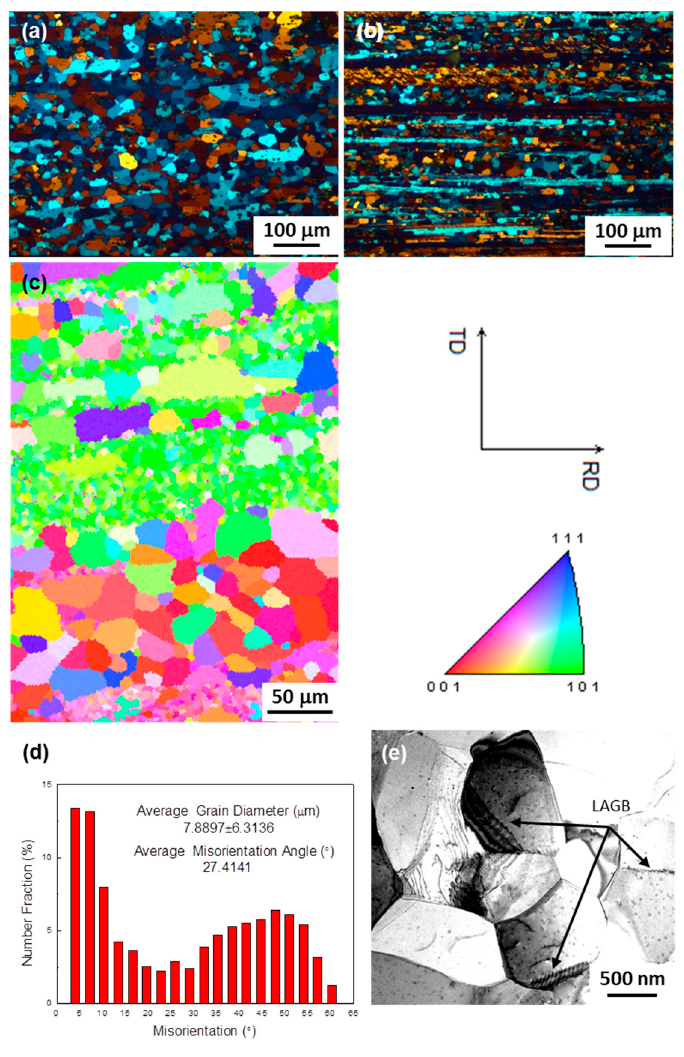
Figure 4. The recrystallization degree of the experimental alloys after solid solution treatment: ( a ) Optic micrography images of the Ce-free alloy; ( b ) OM images of the Ce-containing alloy; ( c ) EBSD image ( d ) grain boundary orientation angle distribution and ( e ) TEM image of the Ce-containing alloy.